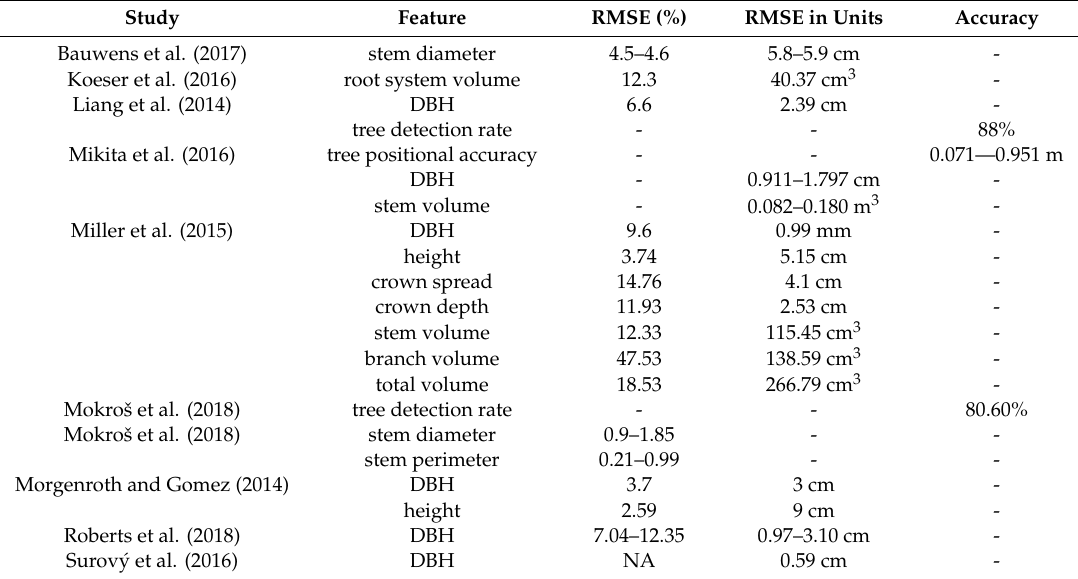
Table 1. Comparison of tree features modeled with close-range